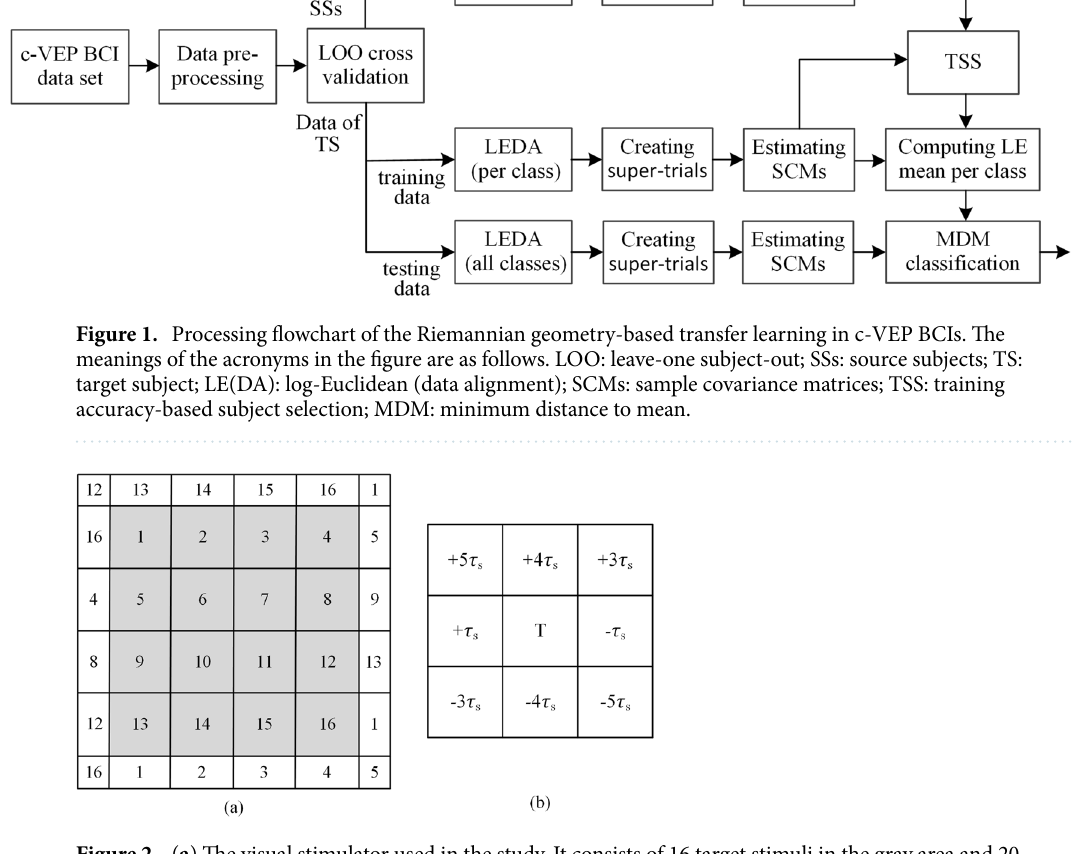
Figure 2. ( a ) The visual stimulator used in the study. It consists of 16 target stimuli in the gray area and 20 complementary non-target stimuli in the white area. The 16 target stimuli are modulated by a 63-bit M sequence and its circularly shifting sequences. The target and non-target stimuli tagged with the same numbers are modulated by the same modulation code. ( b ) The principle of equivalent neighbors is used in design of the stimulator. Each target T and the eight adjacent targets around it maintain a fixed time delay relationship. τ s (4 bits in the study) is the time lag of modulation codes between two adjacent target